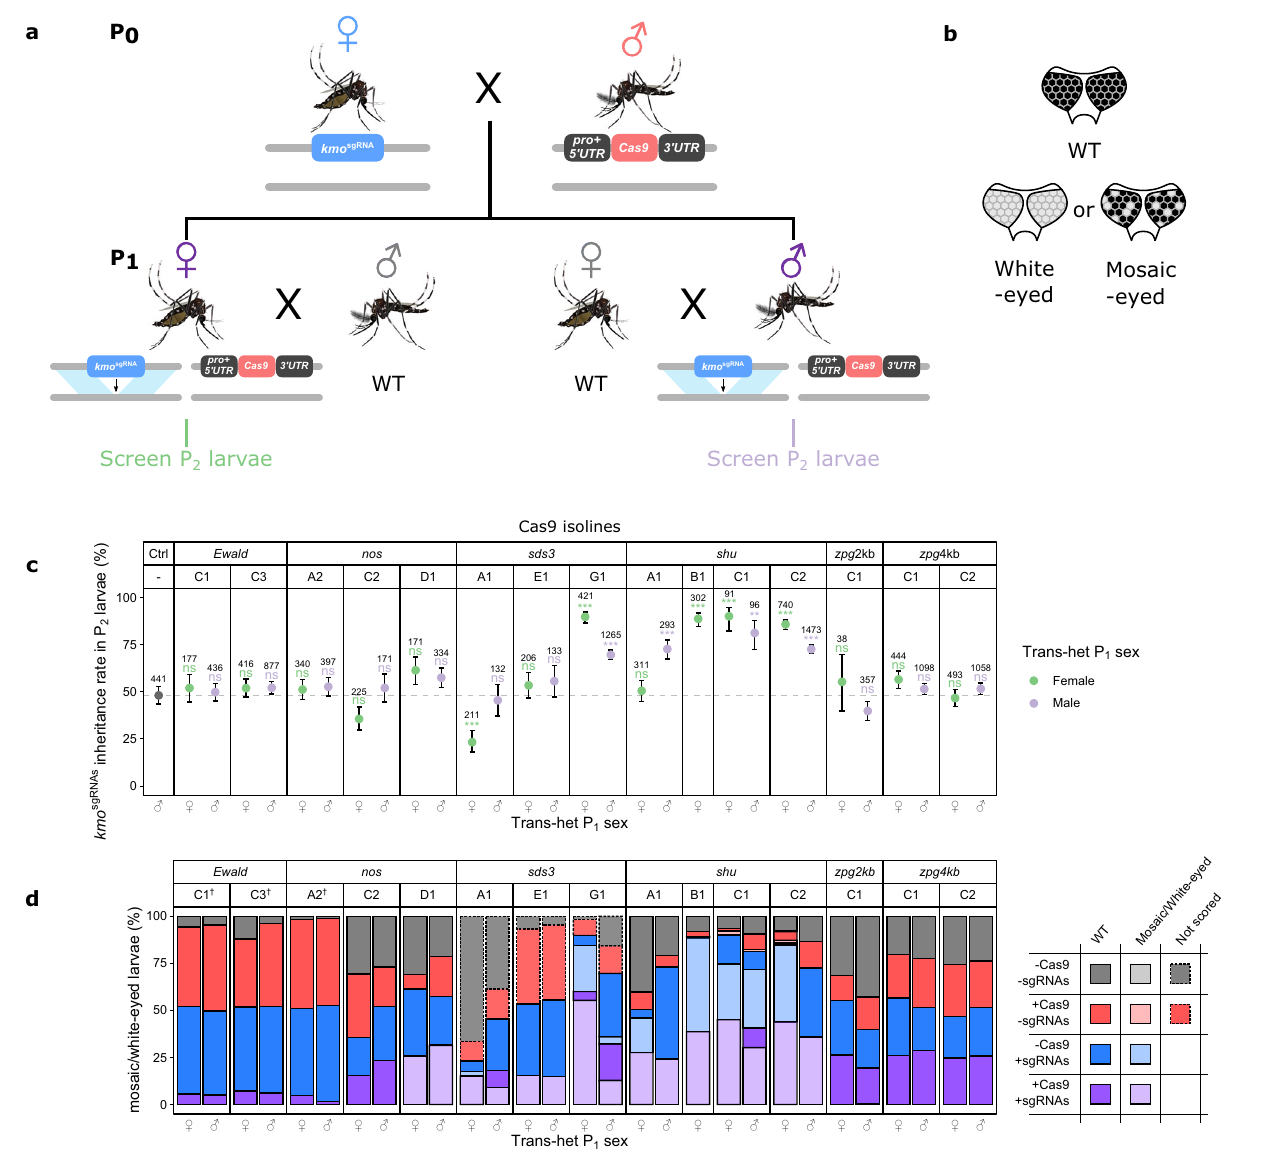
Fig. 1 | Cas9 expressed by sds3 and shu regulatory elementscauses inheritance bias of the kmo sgRNAs element. a Crossing scheme for determination of Cas9- induced inheritance bias. b Illustration of the difference between WT-, mosaic-, or white-eyed phenotype. c Inheritance rate of the kmo sgRNAs in P 2 larvae, scored by AmCyan fl uorescence. Total number of screened larvae from each cross is pre- sented above corresponding data points. Error bars are the Wilson con fi dence intervals forthe binomialproportion.The con fi denceintervalsare calculatedfrom the pooled progeny count and cannot account for potential over dispersal due to parentbyparent ‘ batch ’ effects.Statisticalsigni fi cancewasestimatedusingFisher ’ s